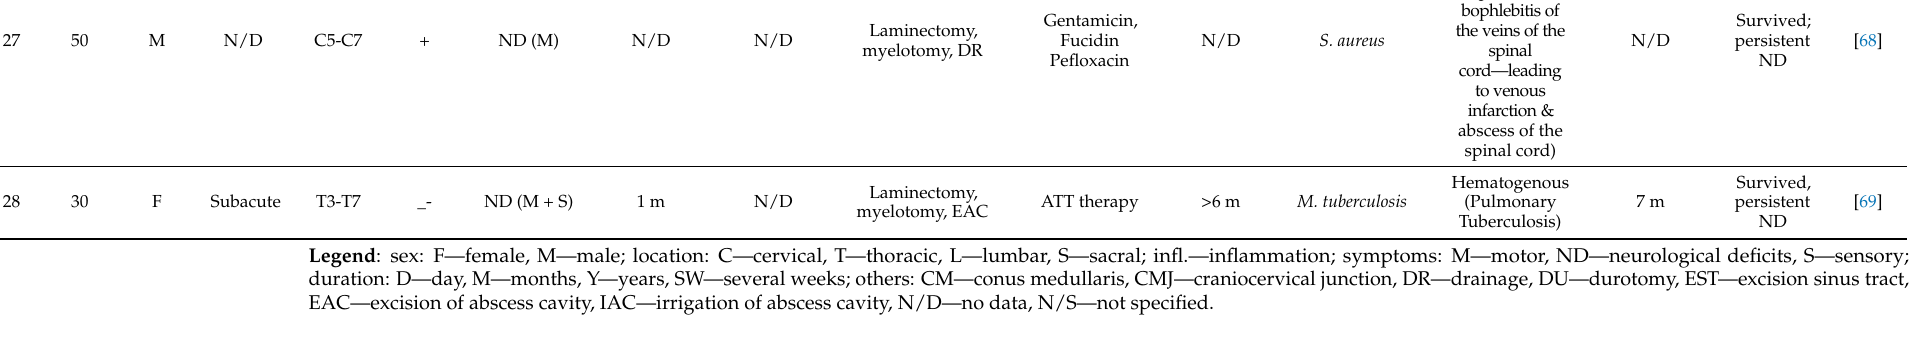
Table 5. Death group—summary of the clinical data, patient demographics, clinical manifestations, duration, microbiology, interventions and therapies,